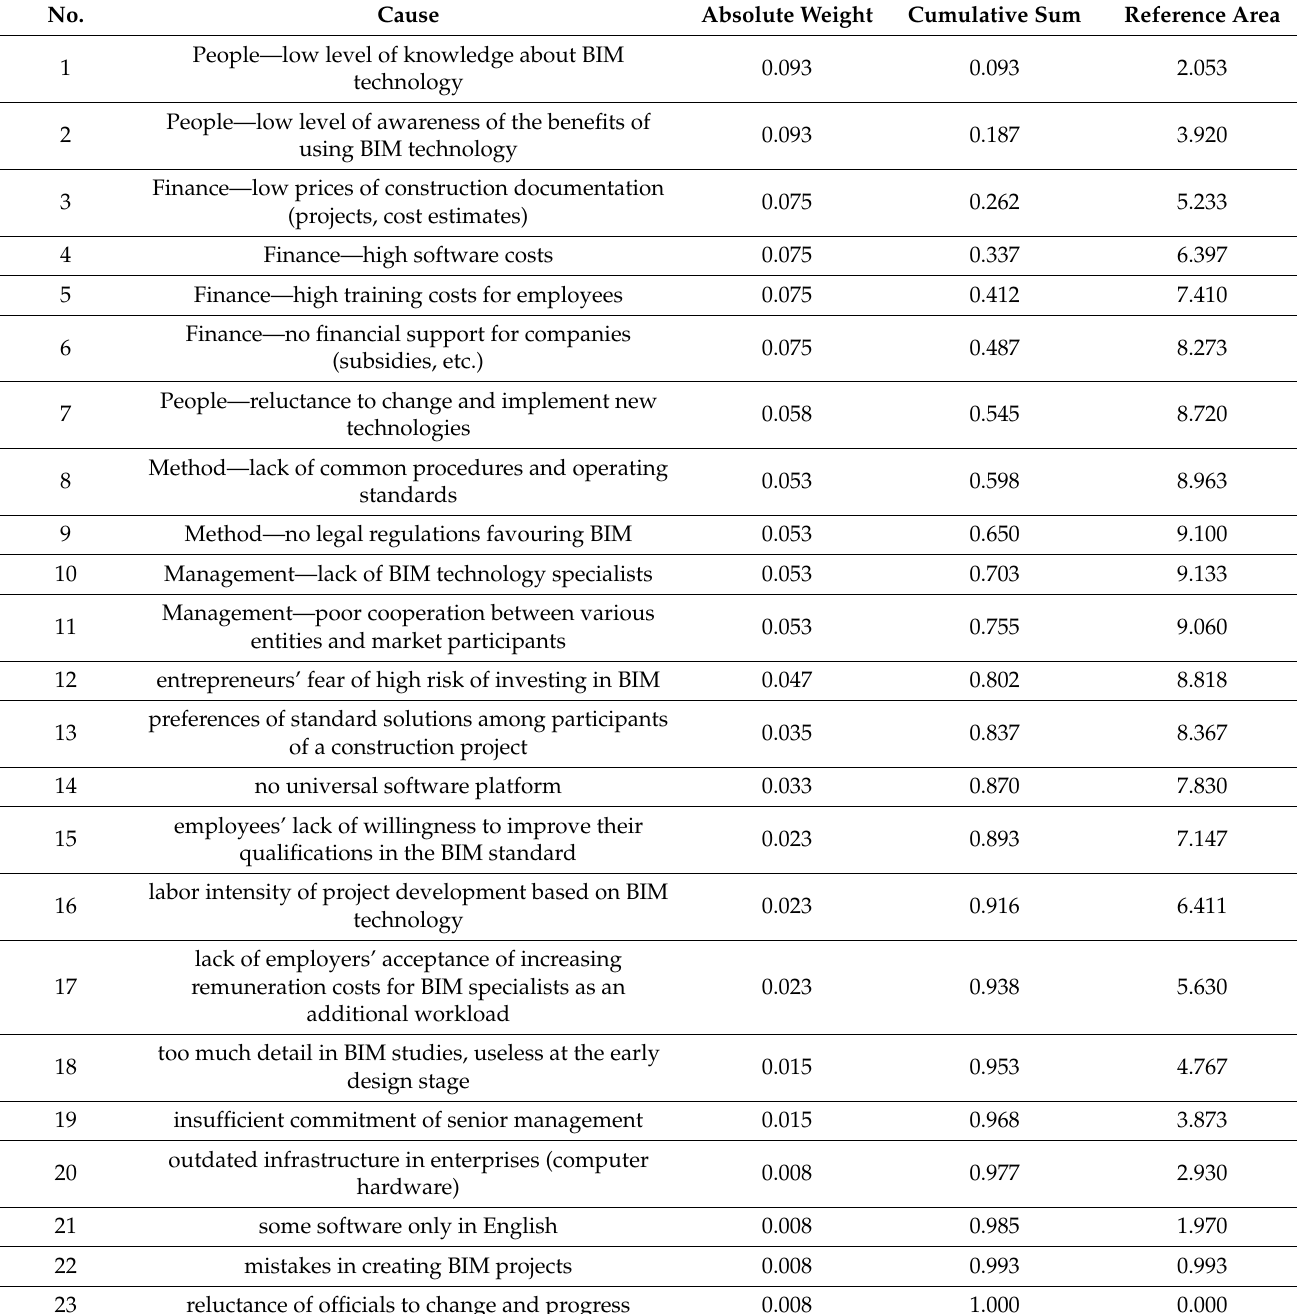
Table 5. Stratification analysis: the most important reasons for the lack of implementation of BIM technology in Poland. No. Cause Absolute Weight Cumulative Sum Reference